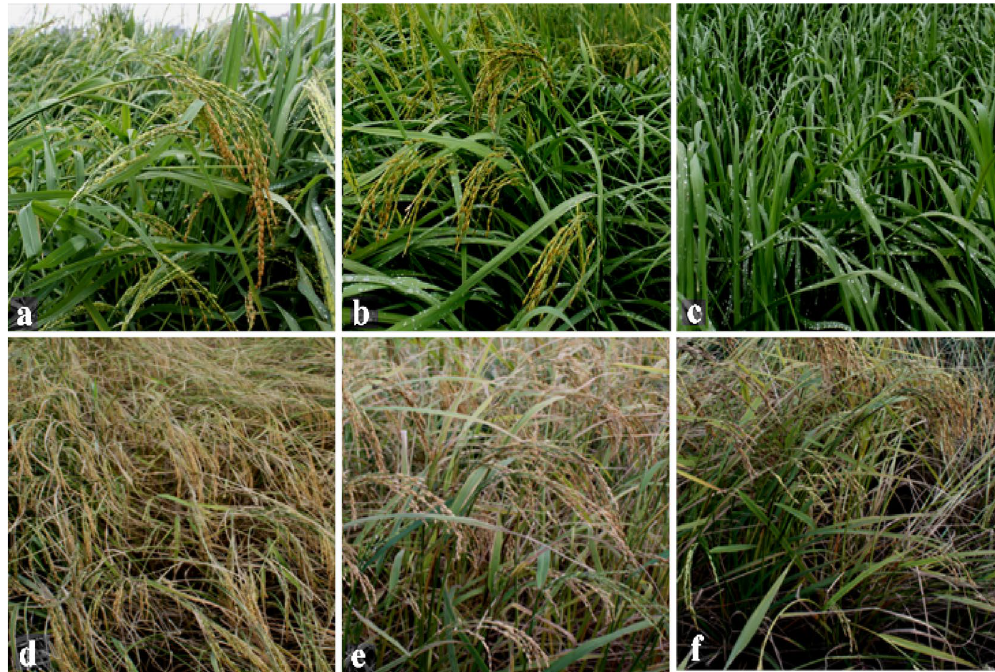
Figure 1. The phenotypic characters of rice landraces under different germination rates. ( a – c ) represents the phenotype characters at heading stage with the germination rates of 80–85%, 65% and 30%, respectively. ( d – f ) represents the phenotype characters at filling stage with the germination rates of 80–85%, 65% and 30%, respectively.